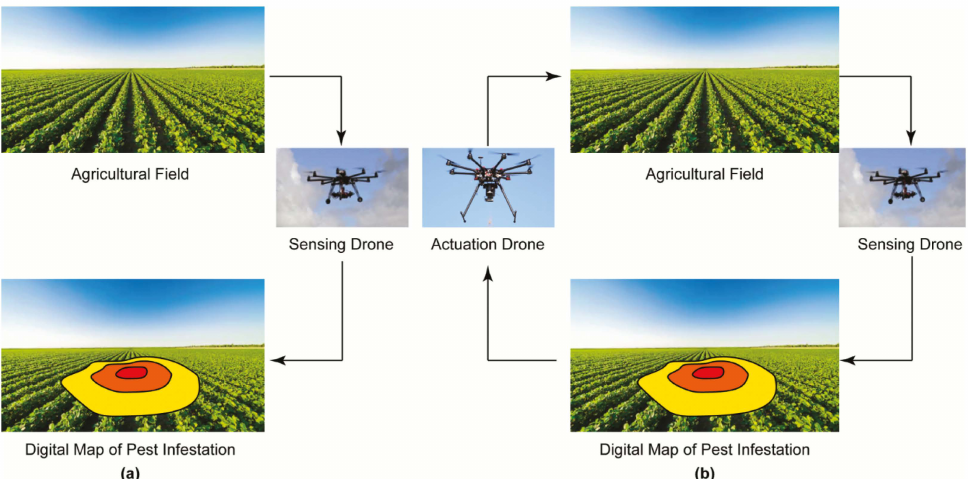
Figure 8. ( a ) State-of-the-art open-loop remote sensing paradigm and ( b ) closed-loop IPM paradigm envisioned in [44]. Sensing drones can be used to detect pest hotspots, while actuation drones can be used for precision distribution of